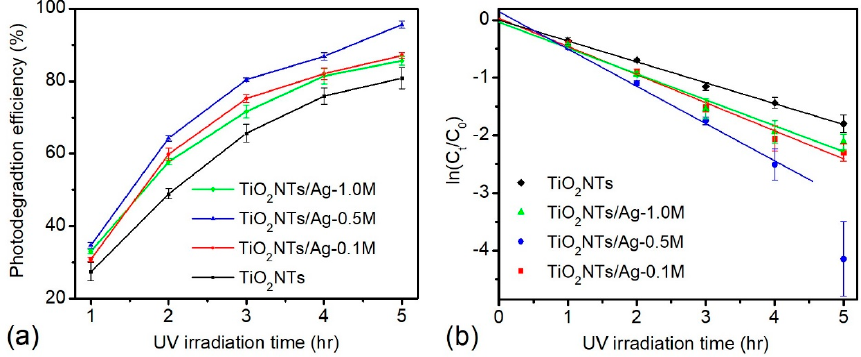
Figure 5. Plots of ( a ) photodegradation efficiency and ( b ) ln (Ct/Co) against UV irradiation time for TiO 2 NTs and TiO 2 NTs/Ag-0.1 M, -0.5 M and 1.0 M catalysts. TiO / Ag-0.1 M, -0.5 M and 1.0 M 2 NTs and TiO 2 NTs